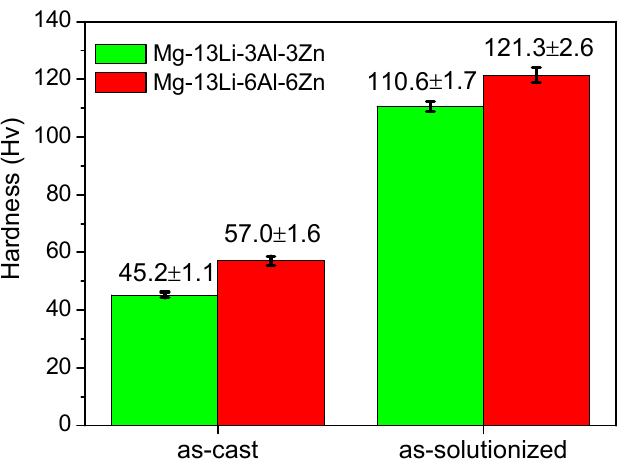
Figure 7. Hardness histograms for as-cast and as-solutionized LAZ13 xy ( x = 3, 6 wt%, y = 3, 6 wt%) alloys.